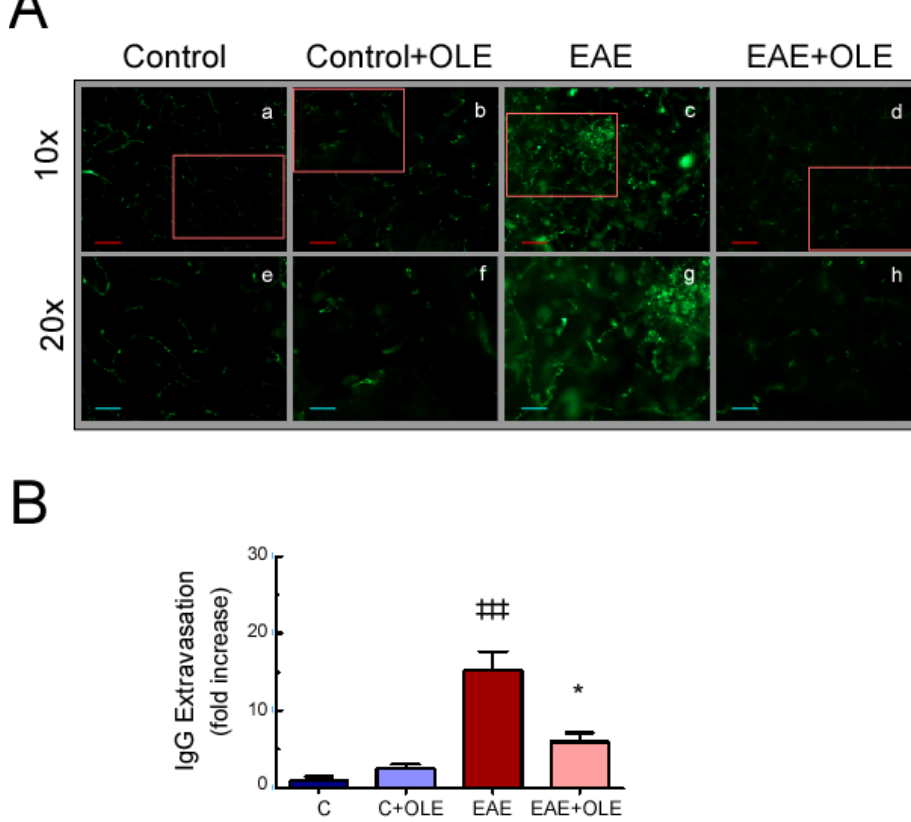
Figure 3. Oleacein treatment reduces blood–brain barrier disruption damage in EAE mice. ( A